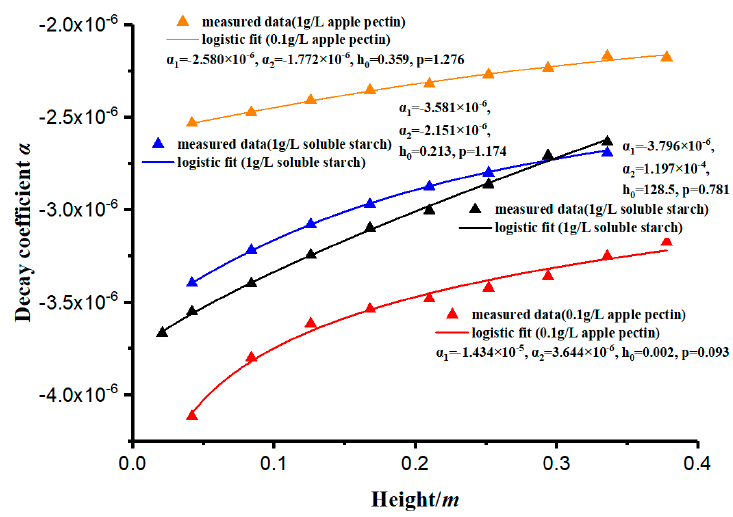
Figure 7. The logistic fitting of the decay constant ( α ).